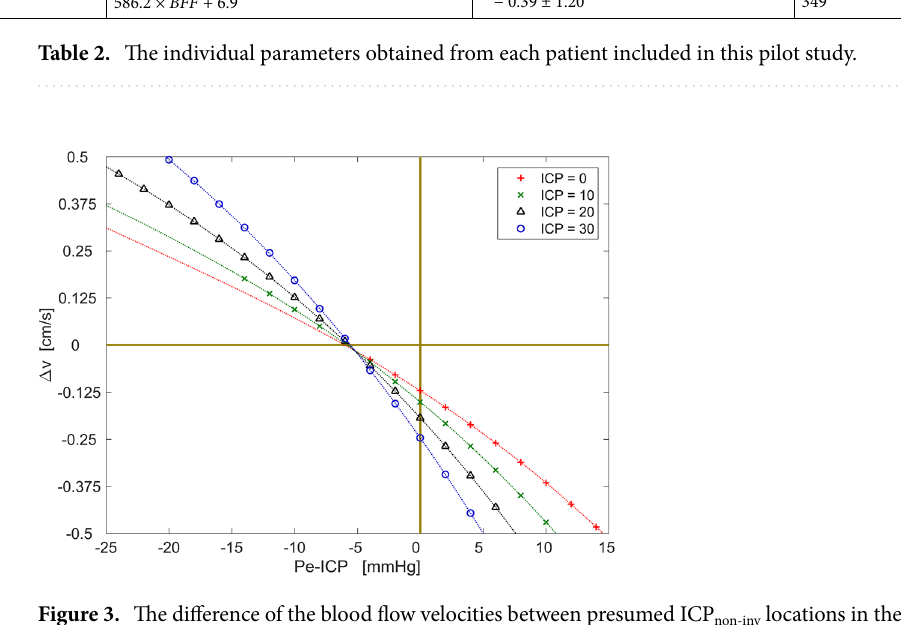
Figure 3. The difference of the blood flow velocities between presumed ICP non-inv locations in the intracranial and extracranial segments of the ophthalmic artery with respect to the intracranial and extracranial pressures. The polynomial curves are fitted to the data points.